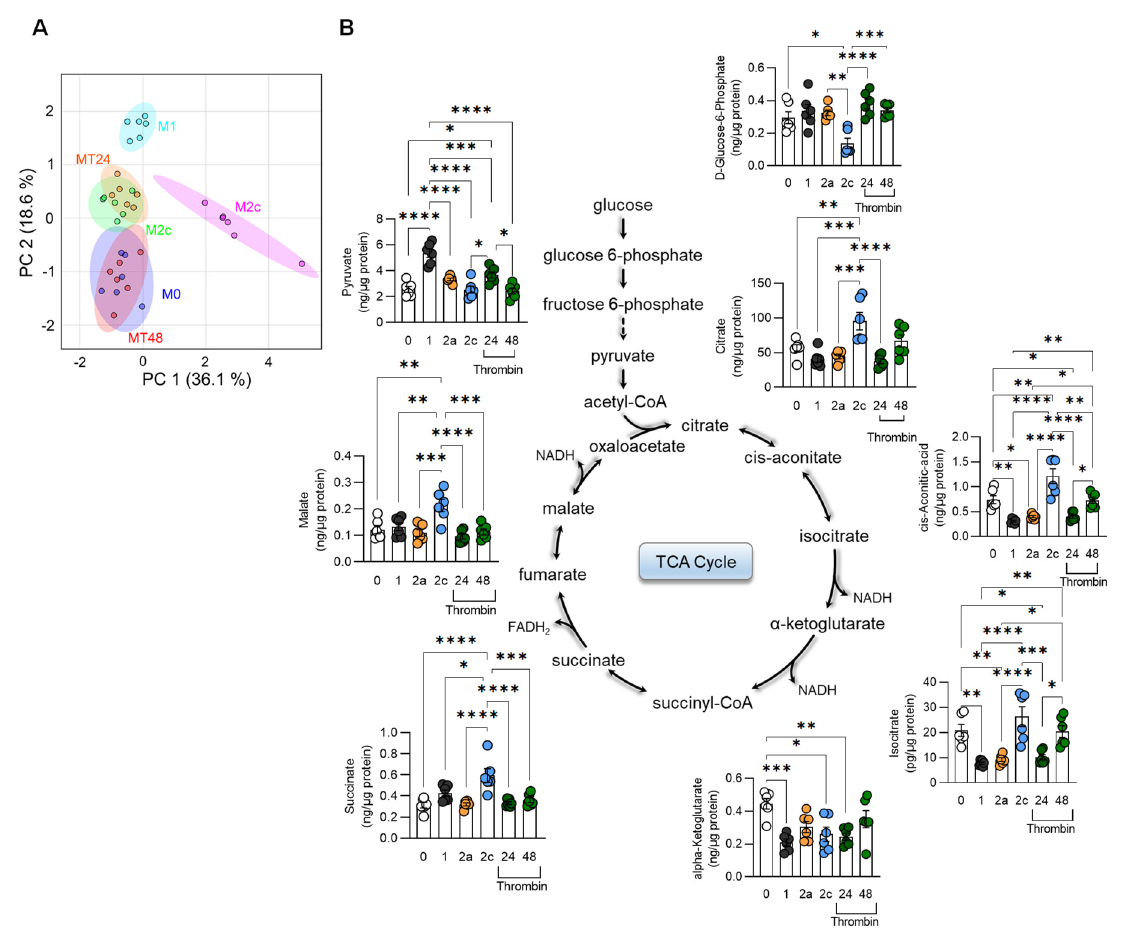
Figure 2. Effects of thrombin on macrophage TCA cycle metabolites. ( A ) Principal component (PC) analysis of TCA and glycolysis-related metabolites of the different macrophage polarization states versus cells treated with thrombin for 24 (MT24) or 48 h (MT48). ( B ) Polarization-dependent changes in specific glycolytic pathway and TCA cycle metabolites; n = 6 mice (one-way ANOVA and Tukey’s multiple comparison test). * p < 0.05, ** p < 0.01, *** p < 0.001, **** p < 0.0001.